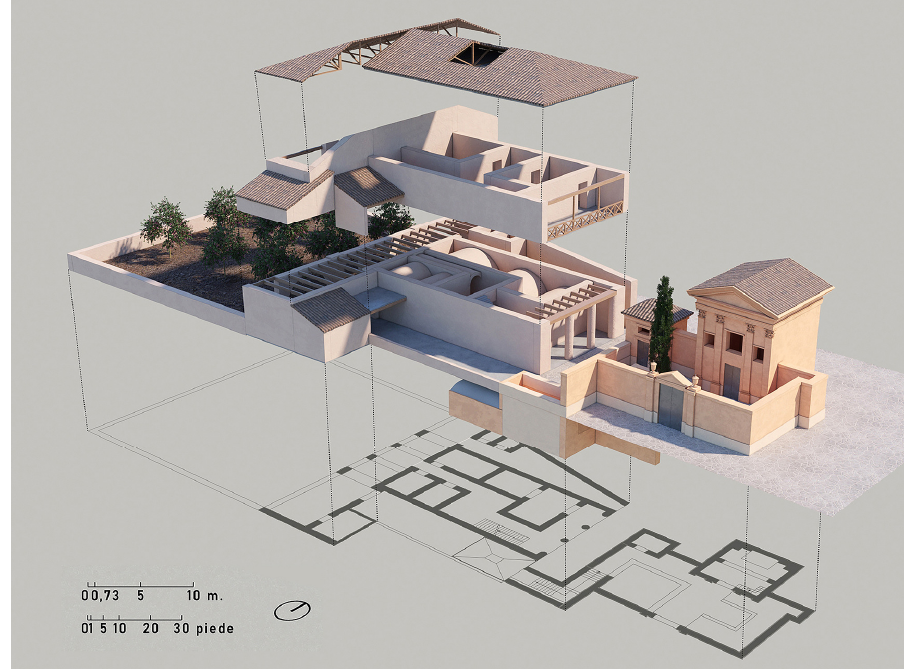
Figure 8. View of the 3D model referred to in graphic virtualizations visible in https://sketchfab.com/3d-models/table-of-perugia-